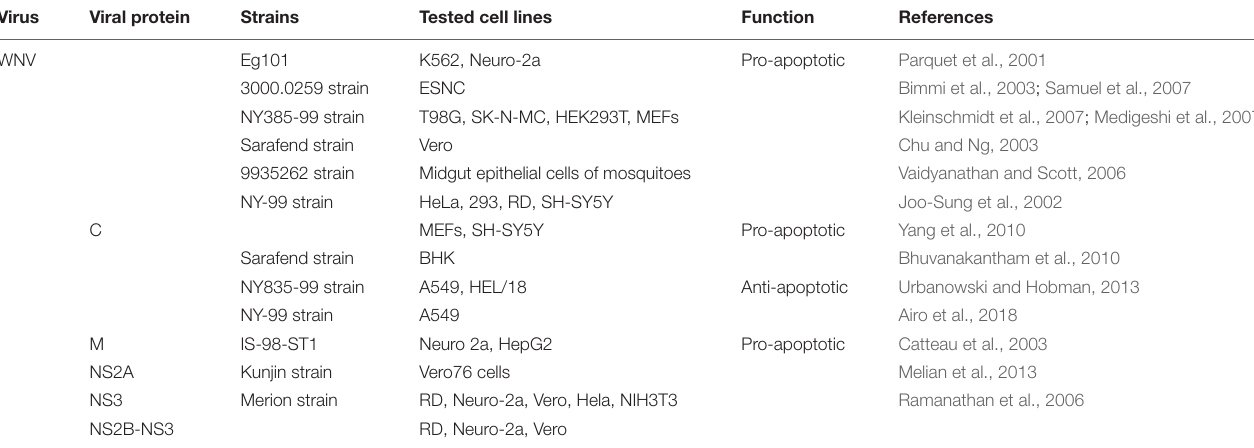
TABLE 2 | Pro-apoptotic or anti-apoptotic activity of WNV and its proteins. Virus Viral protein Strains Tested cell lines